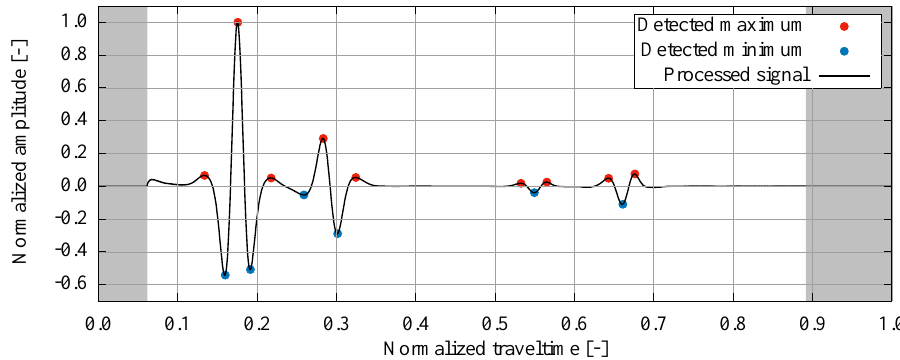
Figure 4. The detected events of the first trace of the synthetic radargram analyzed in Sect. 3.2. The amplitude of a trace is searched for extrema with a neighborhood search algorithm. For the subsequent evaluation, the amplitude of the detected events is normalized to the maximal absolute amplitude of all events detected in the trace. The direct signal and the trailing signal of the dewow filter with normalized travel times < 0 . 06 and > 0 . 89, respectively, are set to zero in a processing step (Sect. 2.3.1) and possible events close to these signals are ignored.